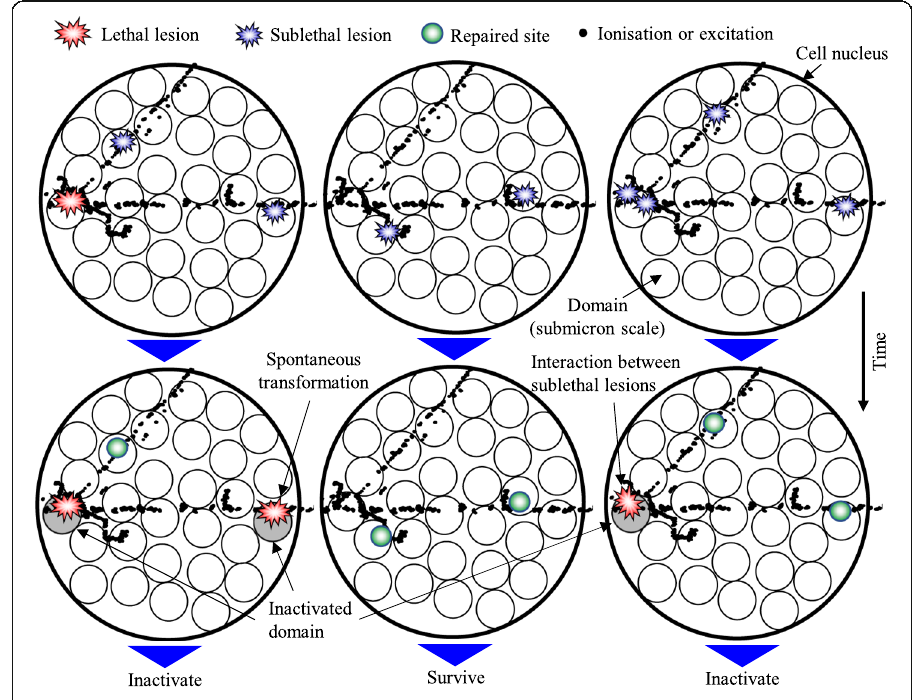
Fig. 9 Schematic drawing of the concept of